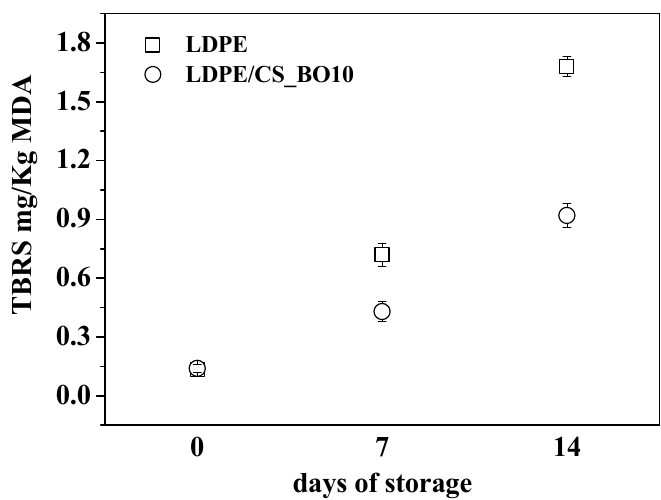
Figure 9. TBARS values of chicken breast fillets vacuum packaged with LDPE, and LDPE/CS_BO10 film after 0, 7, and 14 days of storage at 4 °C.